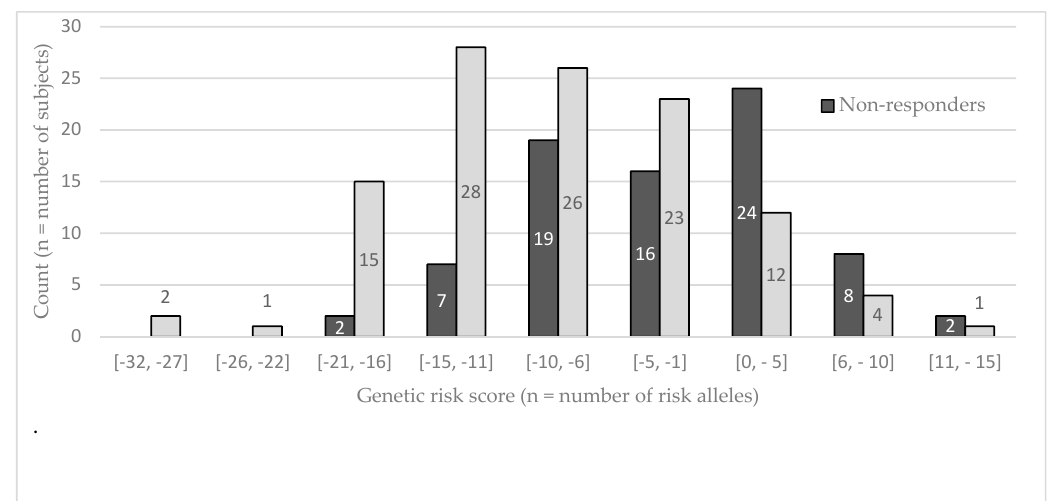
Figure 1. Risk score (GRS) distribution in the Mexican population according to 103 SNPs ( n = 191 individuals). If a GRS is positive, the subject carries more at-risk alleles. If a GRS is negative, the subject carries more beneficial alleles .